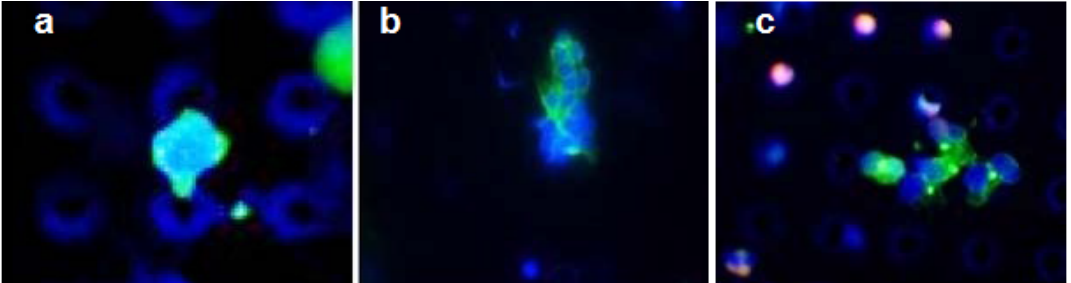
Figure 1: Different size of cancer cells; (a) Breast cancer, (b) Lung cancer, (c) Prostate cancer [19]